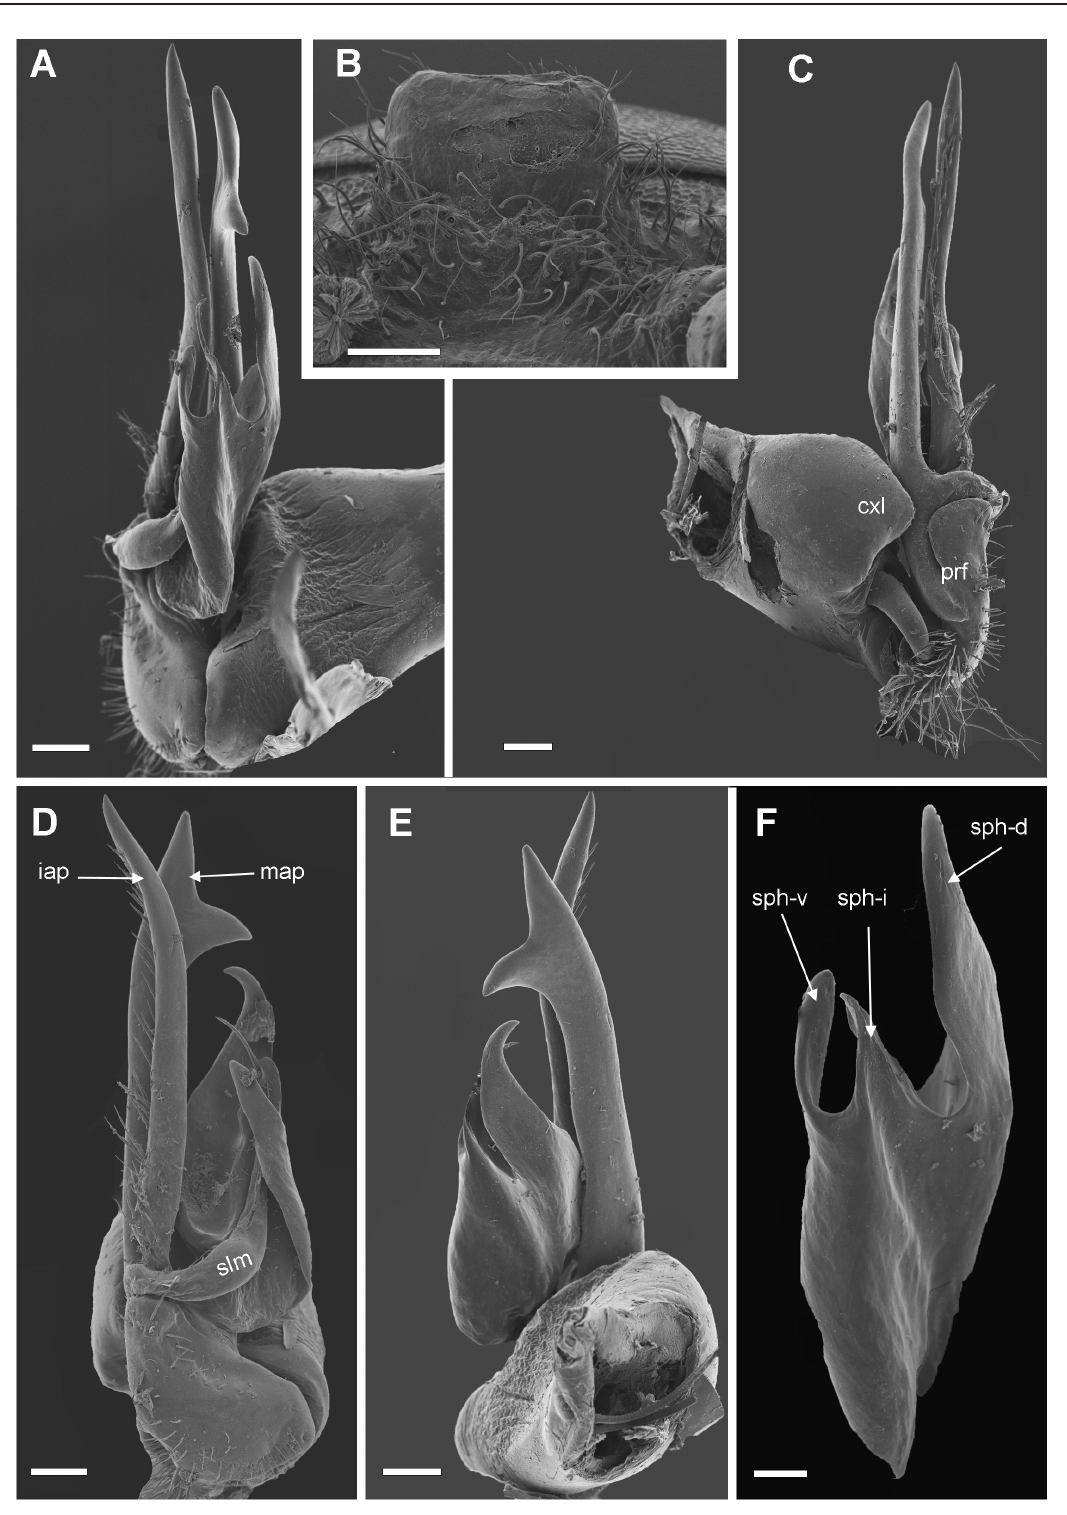
Fig. 14. Eviulisoma chitense sp. nov. paratype. A, C–F . Left gonopod. A. Lateral view. C. Mesal view. D. Ventral view. E. Dorsal view. F. Isolated solenophore, lateral view. B . Lobe between legs 4. Abbreviations: cxl = coxal lobe; iap = intermediate acropodital process; map = mesal acropodital process; prf = prefemoral part; slm = solenomere; sph-d , sph-i , sph-v = dorsal, intermediate and ventral lobes of solenophore. Scale bars: A–E= 0.1 mm; F = 0.05